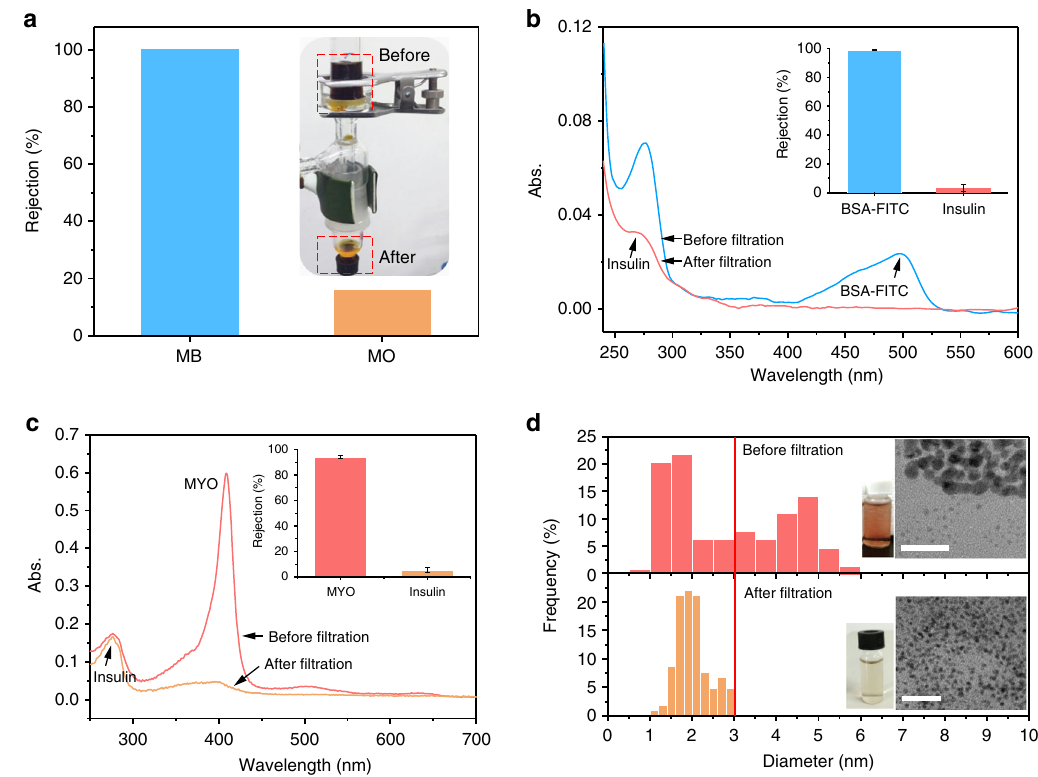
Fig. 5 Pressure-driven fi ltration through the PTL membrane. a Rejection ratios of MB and MO from a dye mixture and the corresponding setup (inset). b UV/Vis spectra and rejection ratios (inset) of a protein mixture (BSA-FITC and insulin) before and after the fi ltration. c UV/Vis spectra and rejections ratios (inset) of a protein mixture (MYO and insulin) before and after the fi ltration. d TEM images and corresponding diameter distributions of gold nanoparticles in the feed solution before (1.0 – 6.0 nm) and after the fi ltration (1.0 – 3.1 nm). Scale bars are 20 nm. Data shown are the average of triplicates with standard